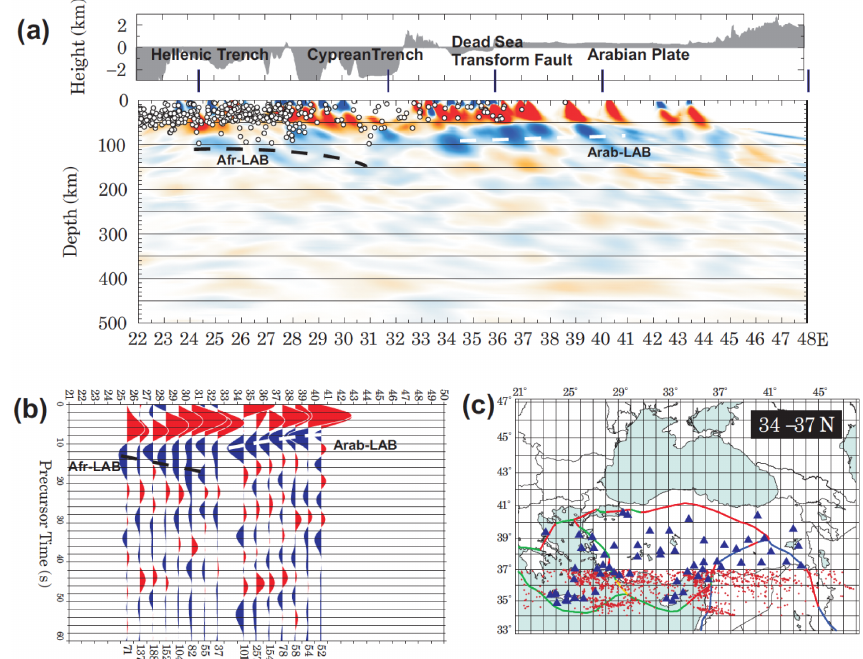
Figure 8. Same as Fig. 5 for an east–west profile between 34 and 37 ◦ N along southern Anatolia. The African LAB appears to deepening from near 100km depth below the Aegean and western Anatolia to about 200km depth at the western edge of Cyprus. Further to the east the LAB is strong and shallow. White circles projected on the migrated depth section of (a) represent the hypocenters of earthquakes between 1998 and 2014 (catalogue of International Seismological